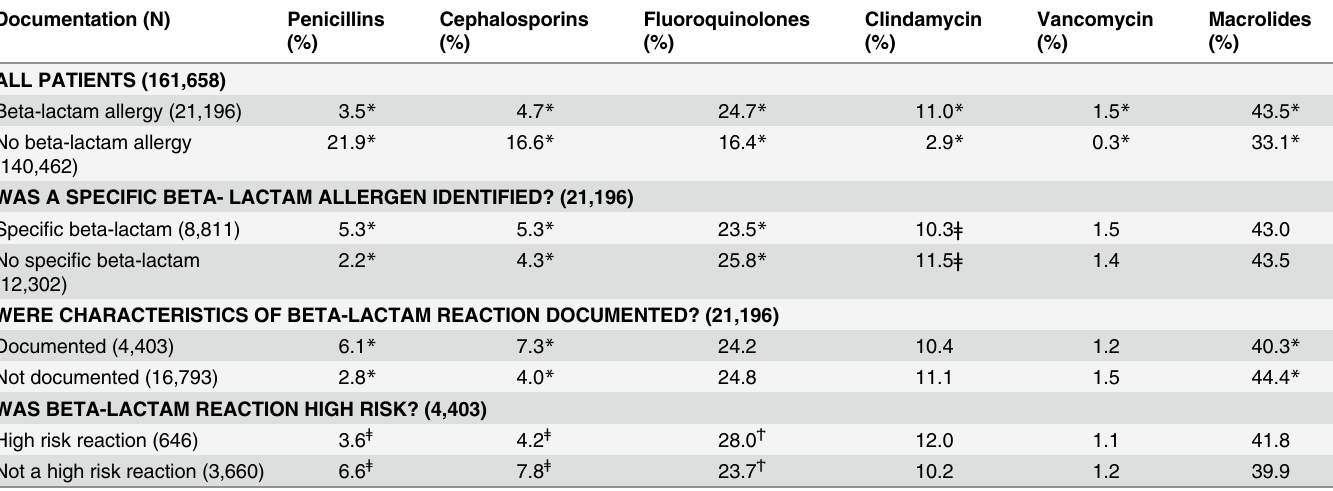
Table 2. Among patients who received an antibiotic, first antibiotic prescribed after antibiotic allergy documentation 1,2 . Documentation